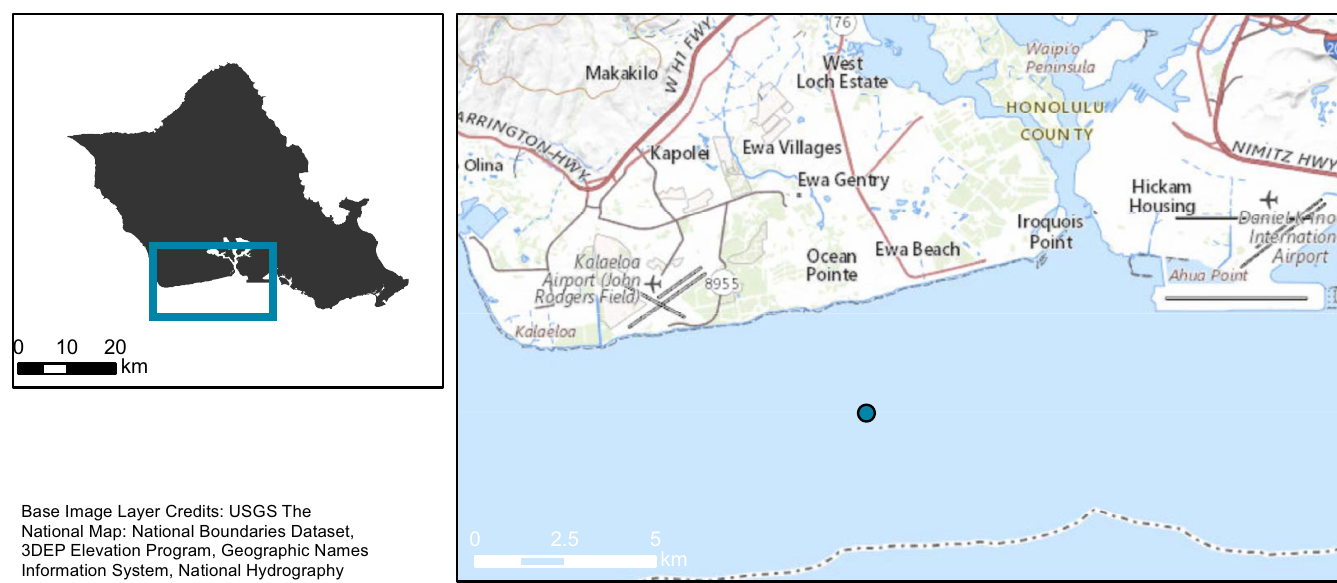
Fig 1. Map of the island of Oahu, Hawaii. The location of the artificial reef complex is depicted in blue. Figure by Tomoko Acoba (NOAA).